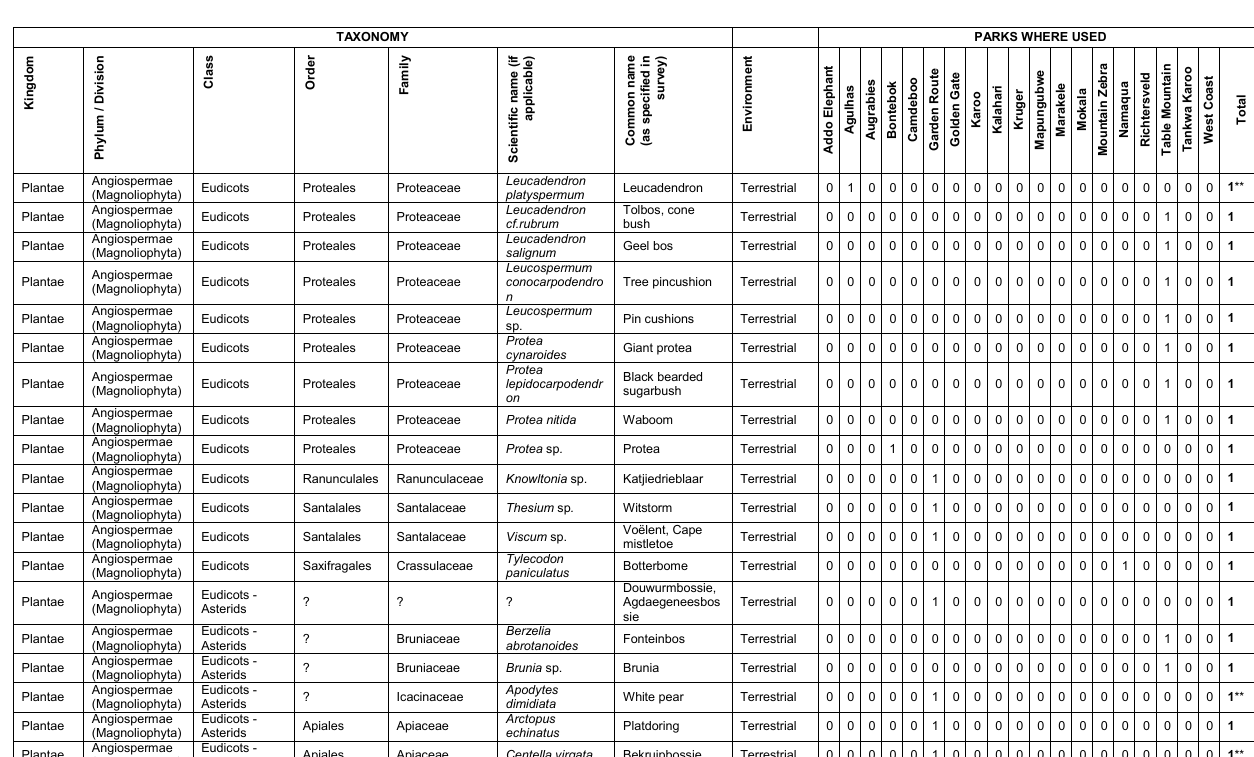
TAXONOMY PARKS WHERE USED